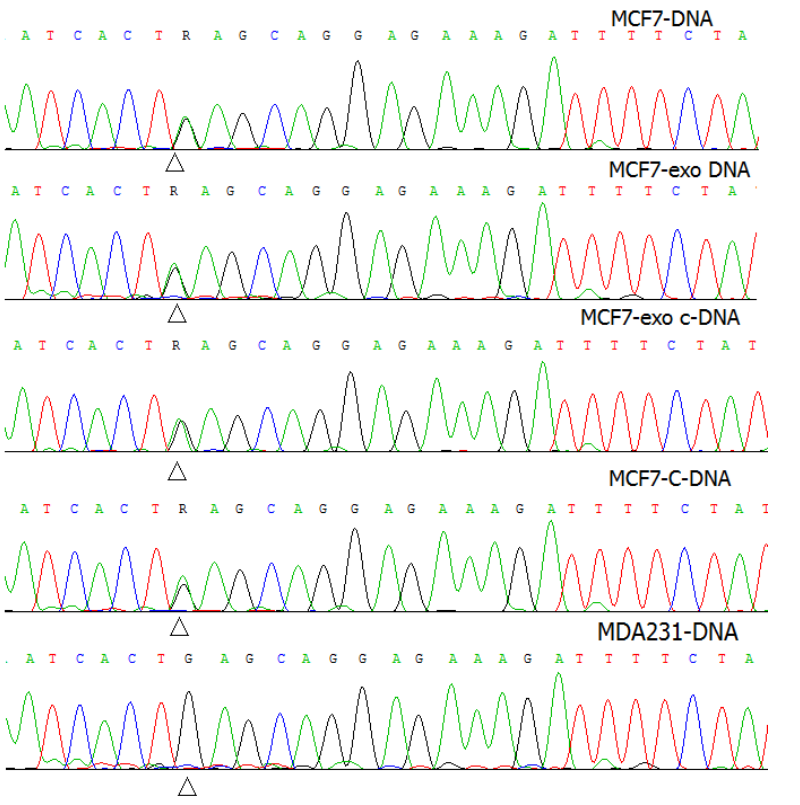
Figure 2. Mutation validation by Sanger sequence analysis. The sequence electrophoregrams of the MCF7-DNA, exosomal DNA from MCF7, cDNA from MCF7, and exosomal cDNA from MCF7 contained the PIK3CA mutation c.1633G > A (p.E545K) (R), compared to the MDA-231 DNA.